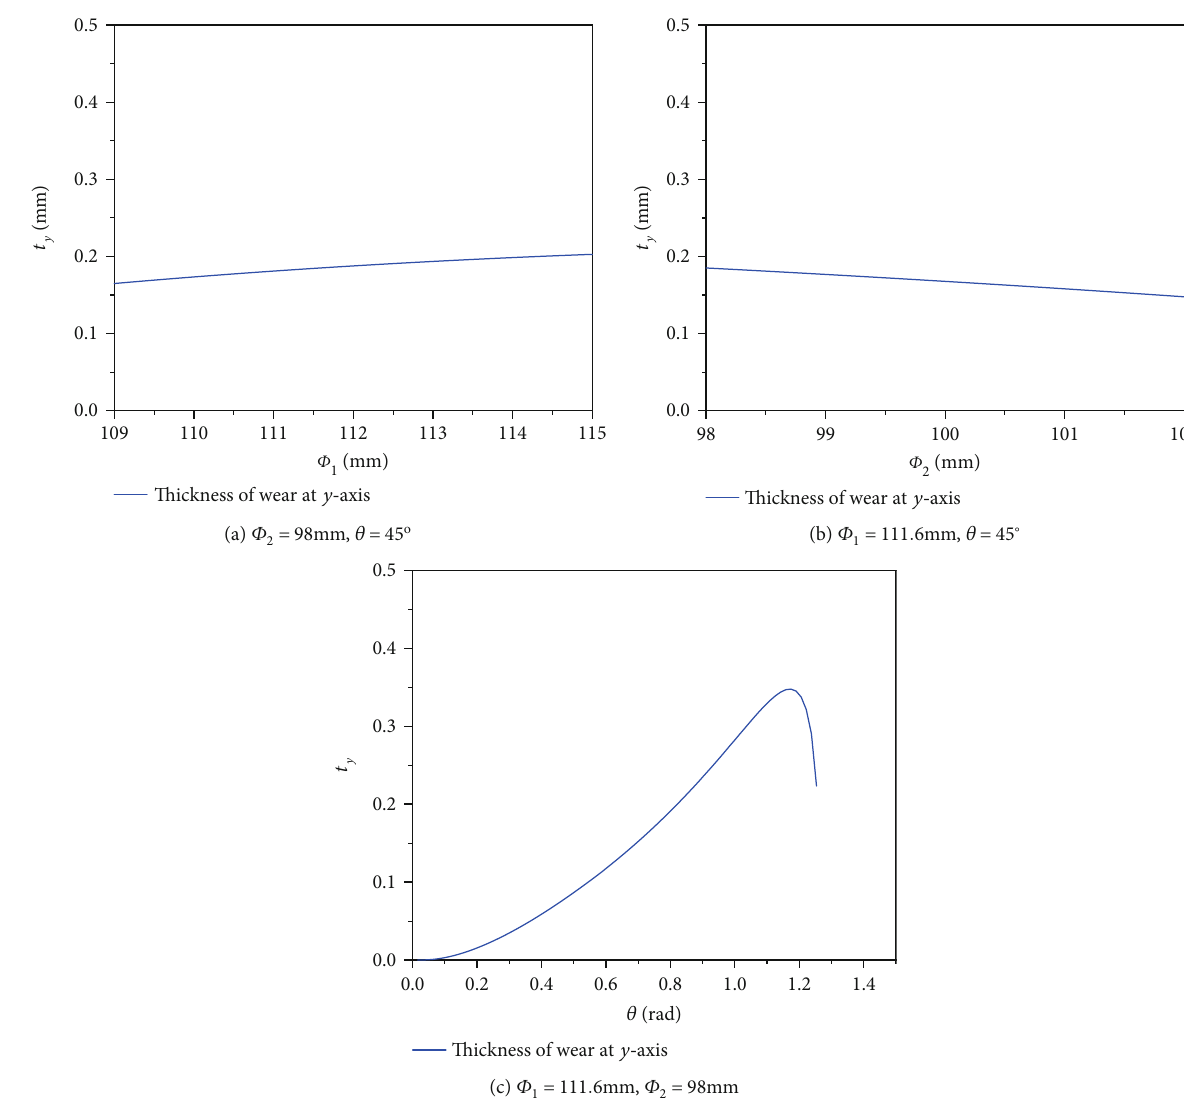
Φ θ , and wear relationship. 1 , 2 ,